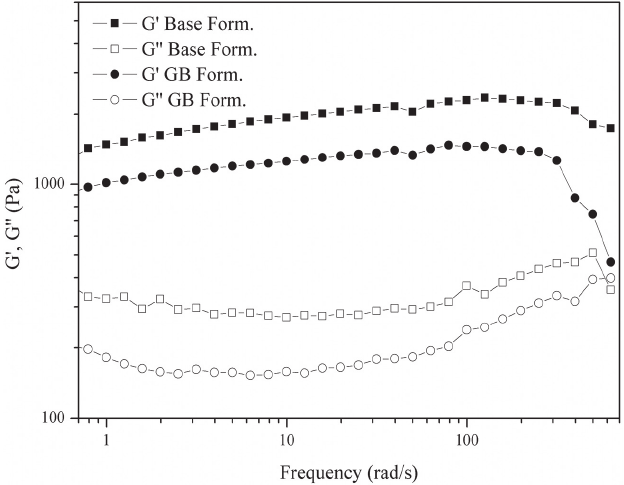
FIGURE 4 - Frequency sweep of the formulations containing or not the GB soft extract.